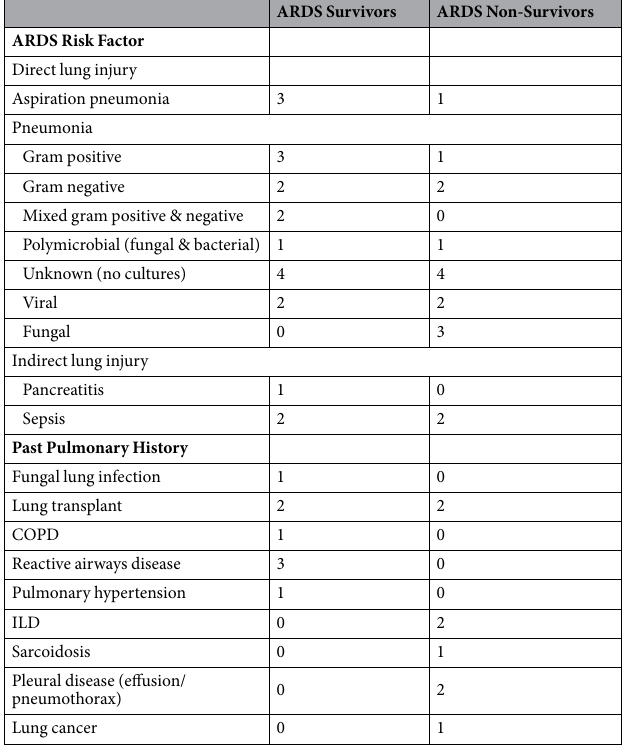
Table 1. Pulmonary History and Clinical Risk Factors for ARDS in Study Subjects. COPD, Chronic Obstructive Pulmonary Disease; ILD Interstitial Lung